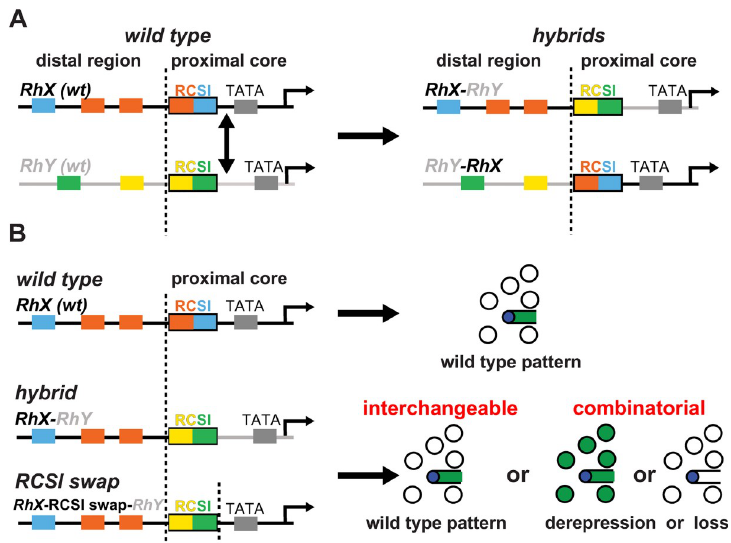
Fig 2. Rhodopsin promoter hybrids and motif swaps to distinguish between two models for proximal core promoter function. (A) Left: Schematic of two hypothetical wild type ( wt ) Rh promoters ( RhX and RhY ) with their distal region and their proximal core region; the latter includes the RCSI motif. The boundary between the distal and proximal core promoter regions just 5’ of the RCSI motif is indicated by a vertical dashed line; replacements of the proximal core promoter regions (indicated by double arrow) were made at this breakpoint. Right: The two resulting hybrid promoters, RhX - RhY and RhY - RhX (the promoter that provided the distal region is named first), have novel distal and proximal motif combinations (colored boxes). (B) Experimental logic. A wild type Rh promoter drives reporter expression (green) in a specific photoreceptor subset (top). If the replacement of the entire proximal core promoter (middle) or only the RCSI motif (bottom) with the one from another Rh promoter resulted in the same wild type expression pattern, then these regions are ‘interchangeable’ between two Rhs . They would thus follow the ‘interchangeable core’ model (bottom right). Alternatively, if such replacements resulted in different patterns— derepression or lack of expression—this means that important proximal motifs have been lost. The latter outcome would suggest that generating the correct pattern requires specific distal and proximal motif combinations, as proposed by the ‘combinatorial core’ model (bottom right).